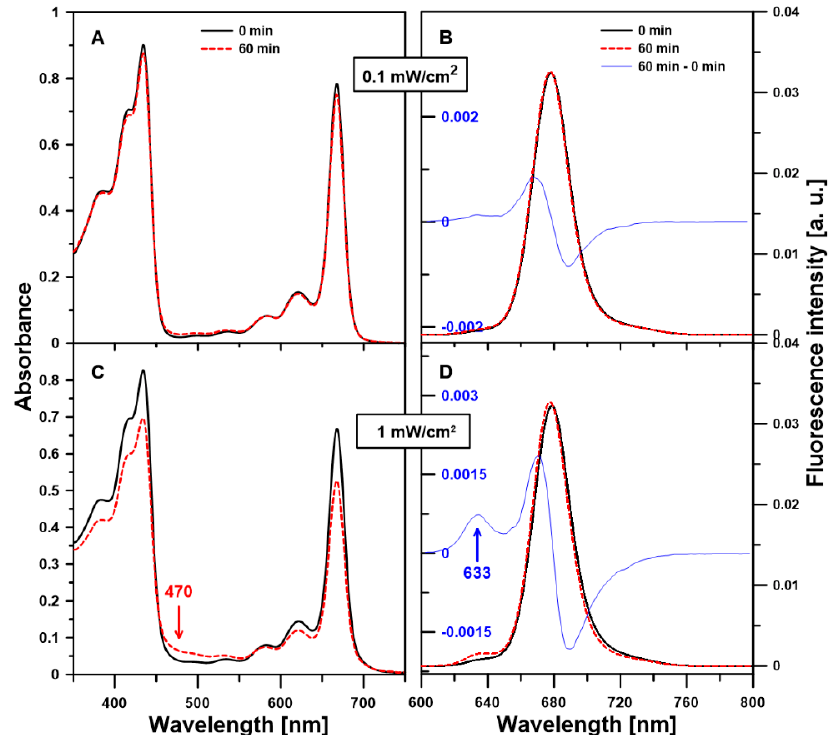
Figure 5. Room temperature electronic absorption and fluorescence emission spectra measured from chl a dissolved in the 5% Cremophor EL nano-emulsion. The molar concentration of chl a in the samples was 10 − 5 M. The spectra were registered directly after the sample preparation (0 min, black solid line) and after the illumination of the samples with white light for 60 min (red, dashed line). The light power was 0.1 mW / cm 2 (panels: ( A , B )) or 1 mW / cm 2 (panels: ( C , D )). The experiment was repeated three times (biological replicates). The representative results are included in the figure. The fluorescence emission spectra were normalized to get the same area beneath each spectrum. Panels ( B , D ) illustrate additionally the di ff erence spectra (60 min–0 min, blue thin line). The emission spectra were registered with excitation at 434 nm.